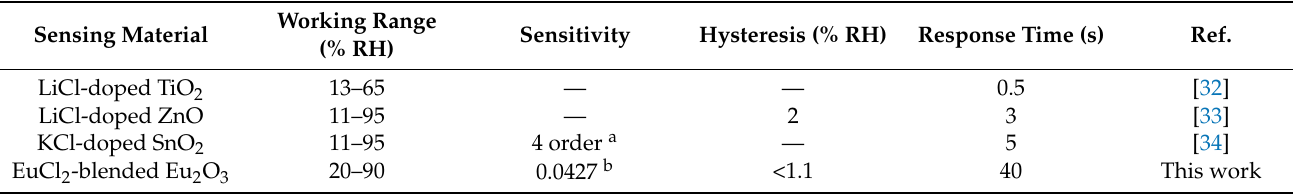
Table 2. Humidity sensor performance of this work compared with the humidity sensors based on ceramic materials in the